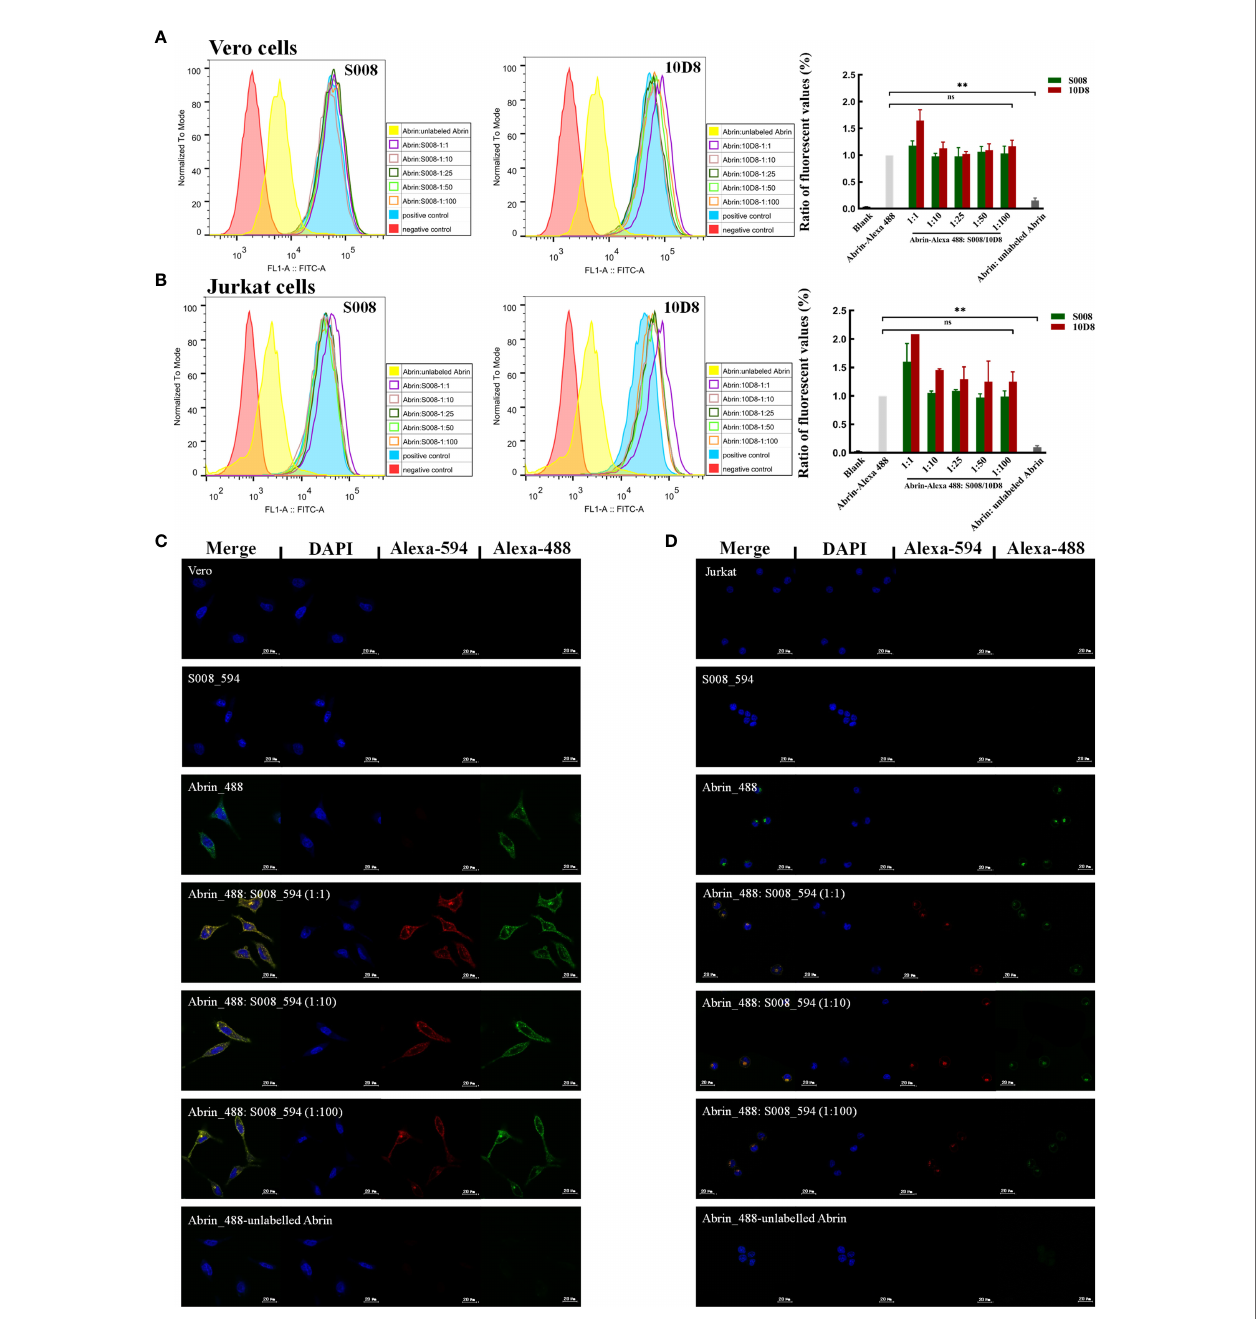
FIGURE 4 | S008 does not inhibit Abrin binding or entering Jurkat or Vero cells. (A, B) FACS analysis of the ability of S008 and 10D8 to block Abrin binding to Jurkat or Vero cells. Intracellular fl uorescent signals of fi xed cells were analyzed using a FACScan system. The ratio of the fl uorescent values of experiment group and positive control group are show. (**P < 0.01; ns, no signi fi cance). (C) Confocal microscopy analysis of S008. (D) Confocal Microscopy analysis of S008. Abrin was labeled with Alexa-488 and S008 was labeled with Alexa-594. Nuclei were stained with DAPI. Images were acquired using Zeiss LSM 880 Meta Laser Con-focal scanning microscope and analyzed using the ZEISS ZEN